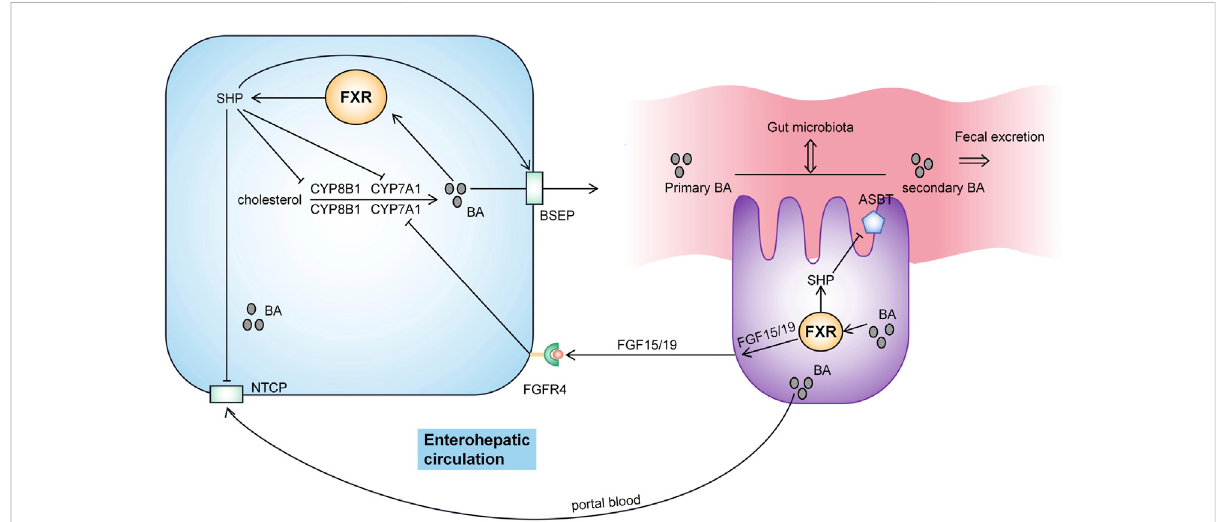
FIGURE 2 Pathway regulating BA metabolism. Hepatic synthesis of BA is a negative feedback mechanism regulated by farnesyl X receptor (FXR). BA is secreted into bile by BSEP and then excreted into the intestine. BA enters the portal vein circulation in the gut through ASBT and is then absorbed mainly by the liver cells via NTCP. BA activates FXR to induce small heterodimer partner (SHP) activity and inhibit the transcription of the CYP7A1 and CYP8B1 genes. Meanwhile, FXR activation increases BA excretion by upregulating the expression of BSEP and ASBT. FXR activation also